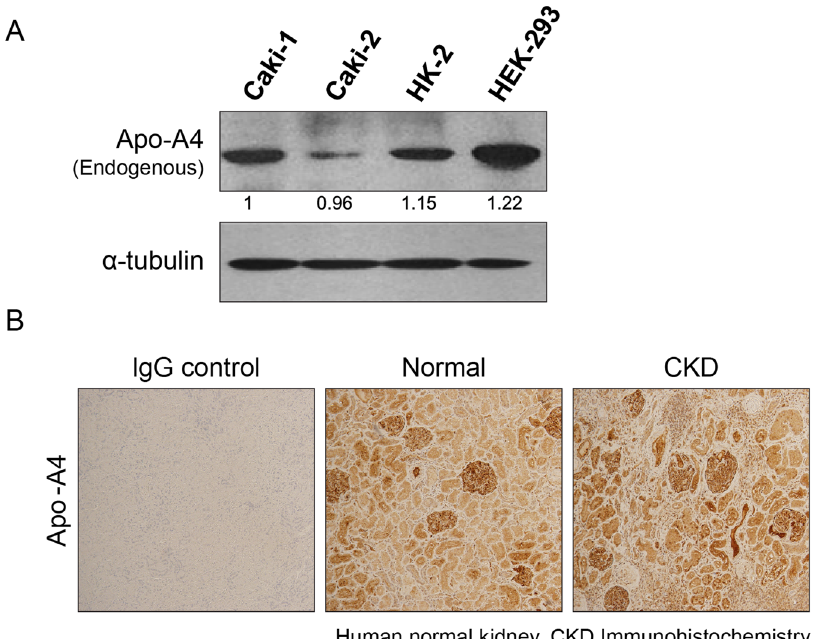
Figure 1. Kidney cell lines and human kidney tissues expressed apo-A4. ( A ) Endogenous apo-A4 protein expression was measured in Caki-1, Caki-2, HK-2, and HEK-293 cells by western blotting. The loading control was α -tubulin. ( B ) IHC of apo-A4 in Formalin-fixed, paraffin-embedded human normal and CKD kidney